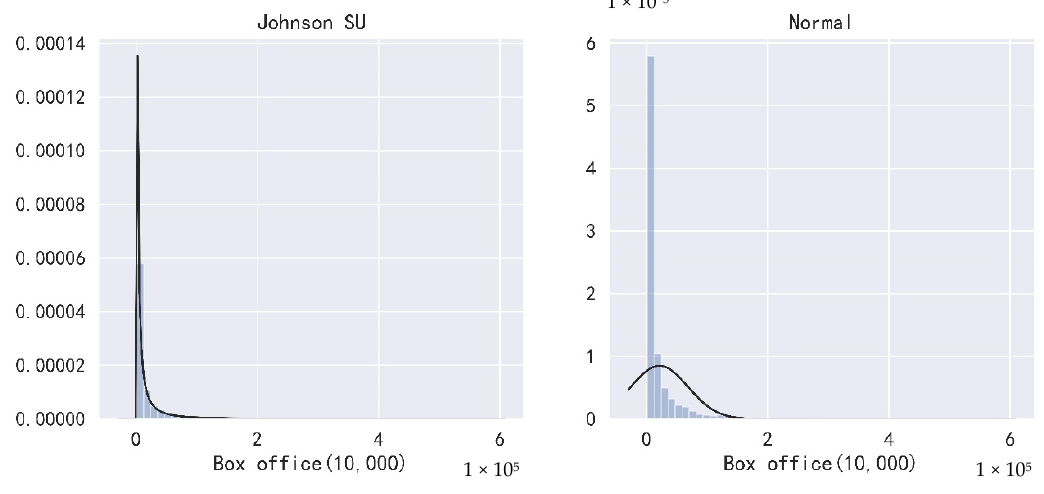
Figure 1. Distribution of total box office (10,000).